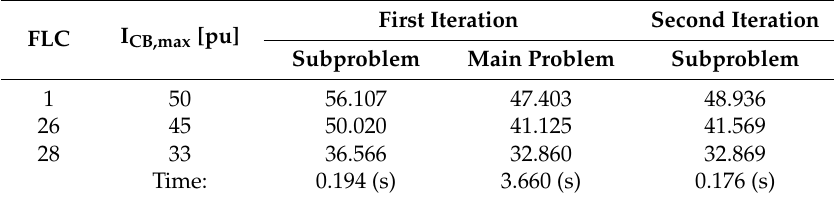
Table 6. Fault current level at each iteration.